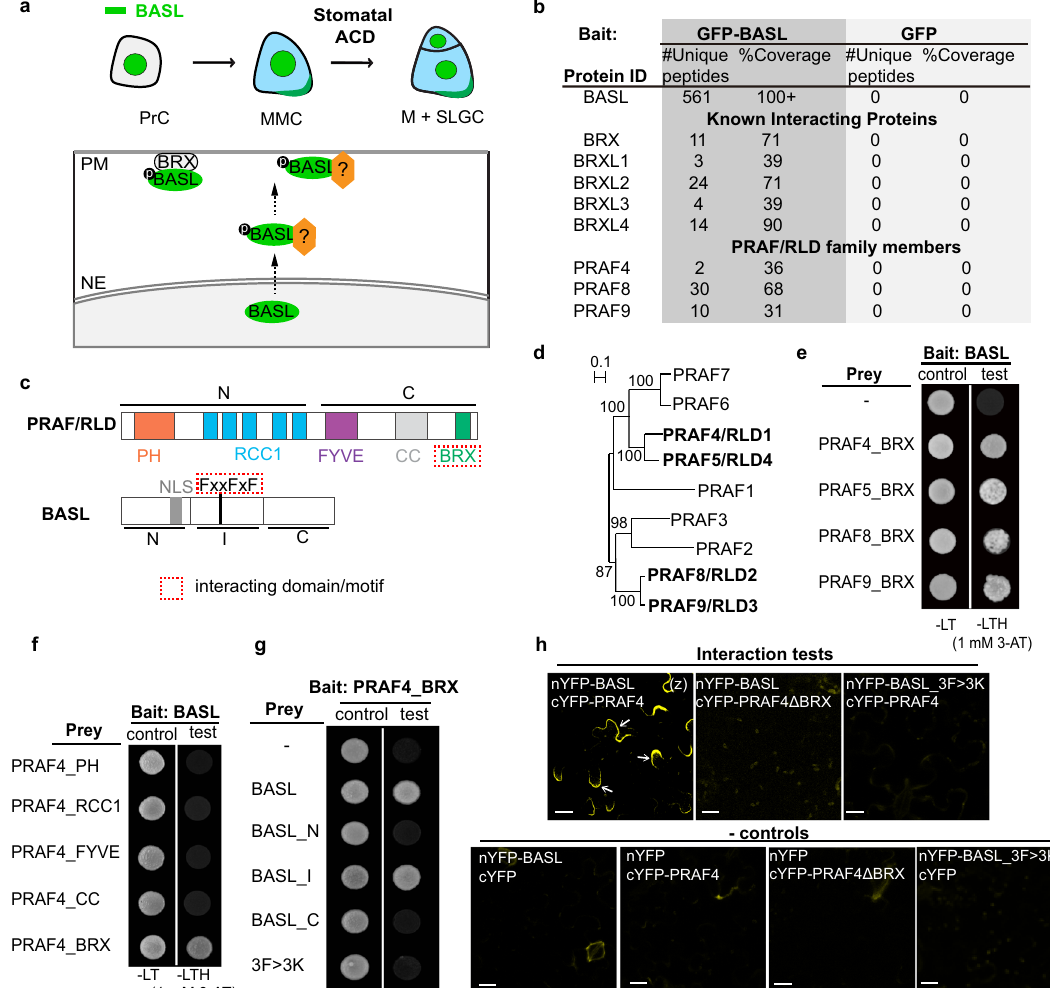
Fig. 1 Identi fi cation of PRAF/RLD proteins as BASL physical partners. a Localization of BASL (green) in Arabidopsis stomatal asymmetric cell division (ACD). PrC protodermal cell, MMC meristemoid mother cell, M meristemoid, SLGC stomatal lineage ground cell. Bottom schematic shows BASL polarization requires MAPK-mediate protein phosphorylation and the plasma membrane-associated BRX proteins. Unknown regulators (orange) are anticipated to mediate BASL polarization. PM, plasma membrane; NE, nuclear envelope. b Results of GFP-BASL co-immunoprecipitation (IP) coupled with mass spectrometry. The ubiquitous 35S promoter was used to drive the expression of GFP-BASL in wild-type plants and proteins associated with GFP-BASL were isolated by GFP-trap agarose beads. GFP alone driven by the BASL promoter was used as control. For details, see Supplementary Data 1. c Subdomains of PRAF/RLD and BASL, respectively. “ N ” , “ I ” , and “ C ” stand for N-terminal, Internal and C-terminal domain of the protein, respectively. “ NLS ” , nuclear localization signal. Dashed red boxes highlight identi fi ed interacting domain/motif. d Phylogenetic tree for the PRAF/RLD family, generated by Clustal W and based on the full-length proteins. Bold indicates proteins further characterized in this study. The AGI numbers can be found in “ Methods ” . e – g Pairwise yeast two-hybrid assays. Bait, designated proteins fused with Gal4 DNA-binding domain (BD). Prey: “ - “ indicates Gal4 activation domain (AD) only, and the others are AD fused with designated protein or protein domain. 3F > 3K (BASL FxxFxF mutated to KxxKxK). “ Test ” indicates interaction assays on synthetic dropout media (-LeuTrpHis, -LTH); “ Control ” indicates yeast growth in rich media (-LeuTrp, -LT). When needed, speci fi c concentrations of 3-Amino-1,2,4-triazole (3-AT) were supplied to suppress bait auto-activation. h Bimolecular fl uorescence complementation (BiFC) assays in N. benthamiana leaf epidermal cells. Positive YFP signals indicate positive protein-protein interactions (BASL with PRAF4). Deletion of the BRX domain (PRAF4 Δ BRX) or mutating the FxxFxF motif (BASL_3F> 3K) abolished YFP signals. White arrows show the interaction occurs in a polarized manner. Data represent the results of three independent experiments. Scale bars = 25 μ m. (z), z-stacked confocal